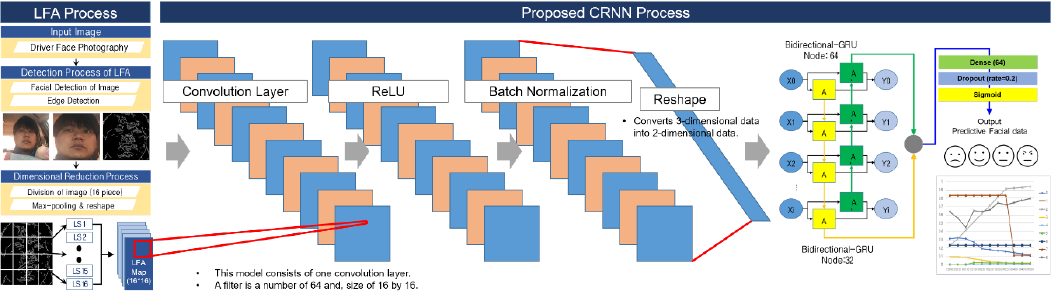
Figure 8. The proposed LFA-CRNN architecture.